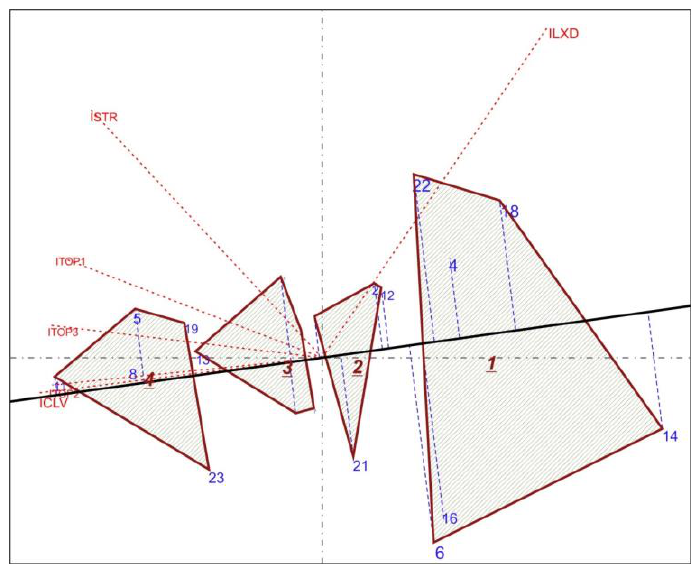
Figure 8. Interactive drawing and study of HJ-biplots and clustering of texts belonging to data set 2, with 24 texts. Blue numbers mean texts. Red strings mean latent variables.